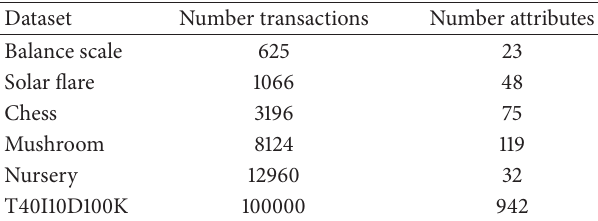
Table 4: The specifications of data